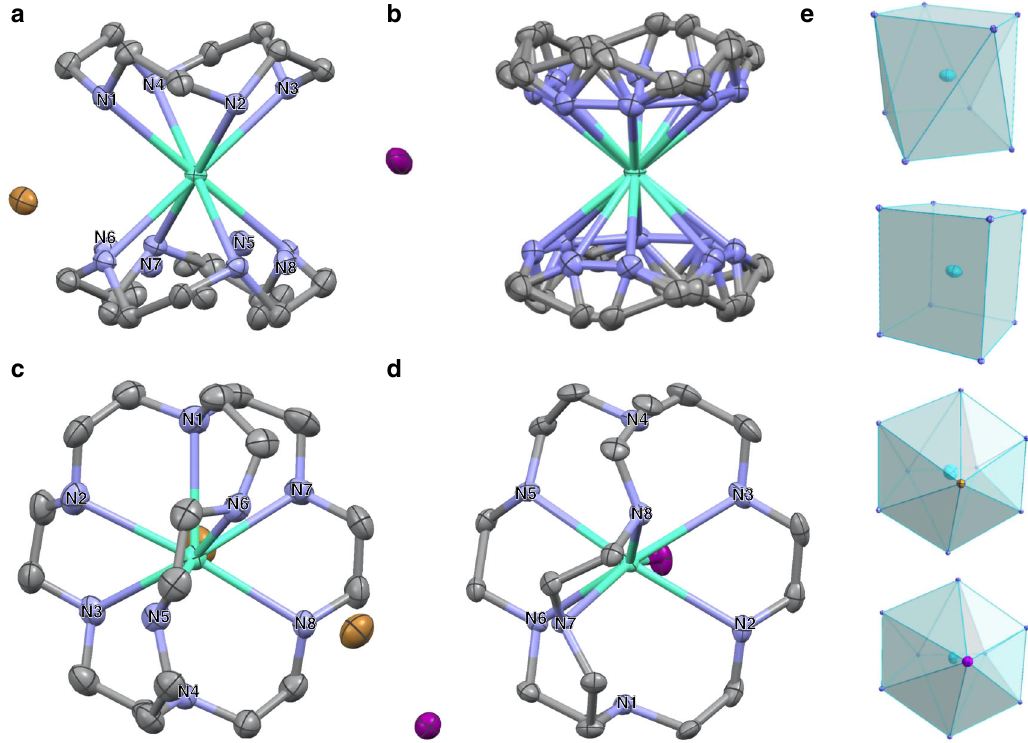
Fig. 1 The crystal structure of four Eu 2 + complexes. ORTEP drawings of the crystal structures of ( a ) EuBr 2 – N 4 , ( b ) EuI 2 – N 4 , ( c ) EuBr 2 – N 8 , and ( d ) EuI 2 – N 8 , respectively. e The coordination polyhedrons (from top to bottom): square antiprism in Eu X 2 – N 4 , distorted cube in Eu X 2 – N 4 , distorted “ hula-hoop ” in EuBr 2 – N 8 and EuI 2 – N 8 . The nitrogen atoms are labeled from N1 – N8 for the data in Table 1. The solvent methanol (in EuBr 2 – N 4 and EuI 2 – N 8 ) and all the hydrogens are omitted for clari fi cation. Atom notation: Eu (cyan), C (gray), N (blue), Br (brown), I (purple).